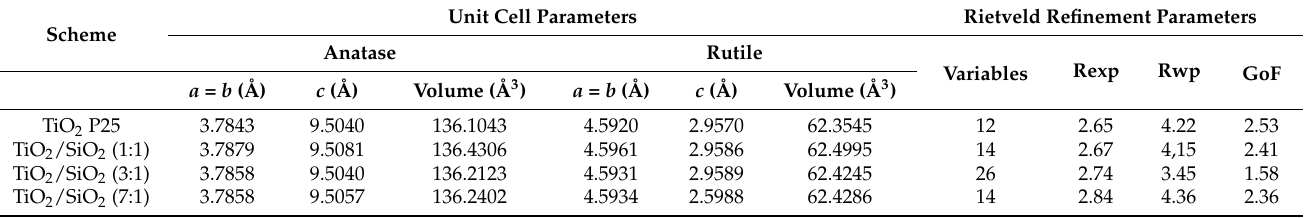
Table 3. Rietveld refinement parameters and unit cell parameters of the samples.